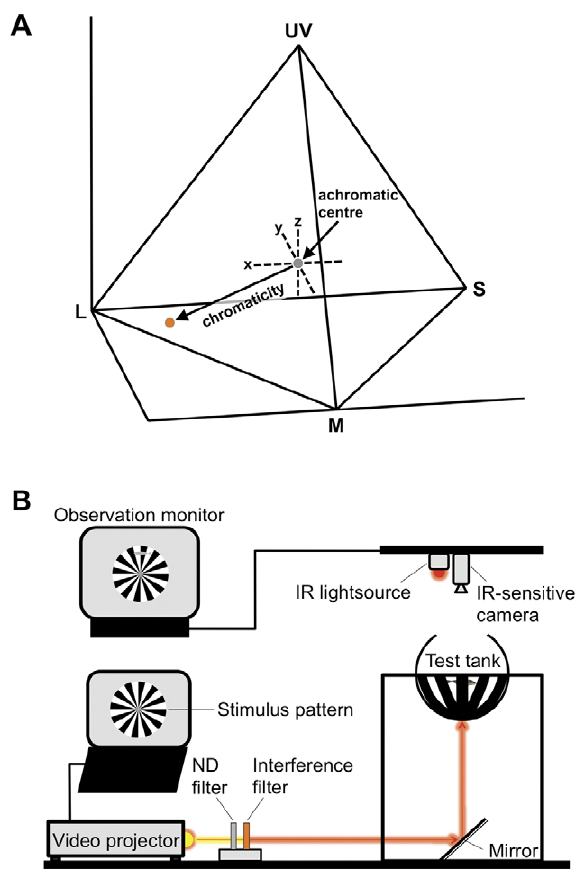
Figure 1. Methods used for measurement of male red coloration and female red sensitivity. (A) Color tetrahedron based on stickleback spectral sensitivity functions with each of the four corner points representing the exclusive excitation of a single cone (UV, S, M, L). The three independent coordinates x, y and z define the position of a spectral color in the three-dimensional space. Chromaticity was determined as the distance between a measured color point (orange dot) and the achromatic origin (grey dot) and represents the degree of chromatic difference between both locations. (B) Schematic represen- tation of the optomotor setup used to measure visual sensitivity of female threespine sticklebacks. Test fish were exposed to a rotating stimulus pattern under three different stimulus wavelengths in the orange-red spectral region (590, 610 and 630 nm) generated by interference filters. To determine threshold sensitivity levels light intensity was increased in five steps by using a series of ND filters (see text for